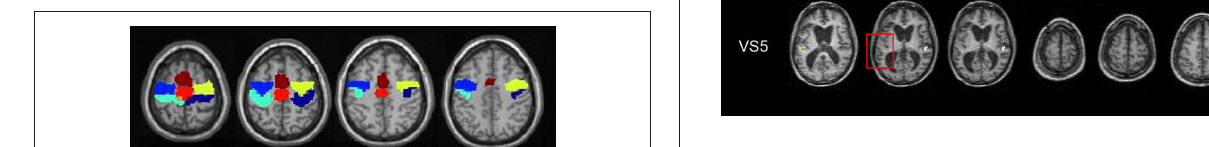
Figure 3 | Functional results from the whole-brain fixed-effect univariate analysis. Activation of temporal (red squares) and premotor cortex (green circles) is shown for patients VS1 through VS5 (top to bottom) when comparing right-hand commands vs. rest. All BOLD activity maps are superimposed on each individual’s structural image. Statistical threshold level was set at p < 0.003 for illustrative purposes.